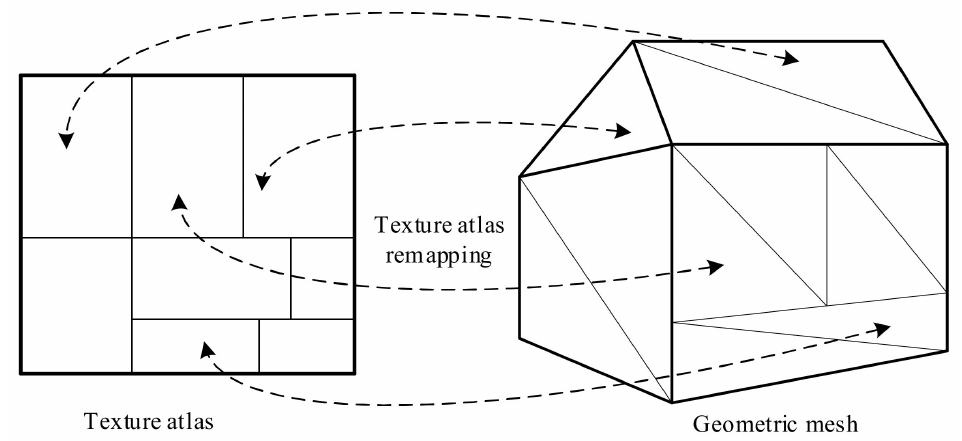
Figure 4. Texture atlas remapping sketch map.